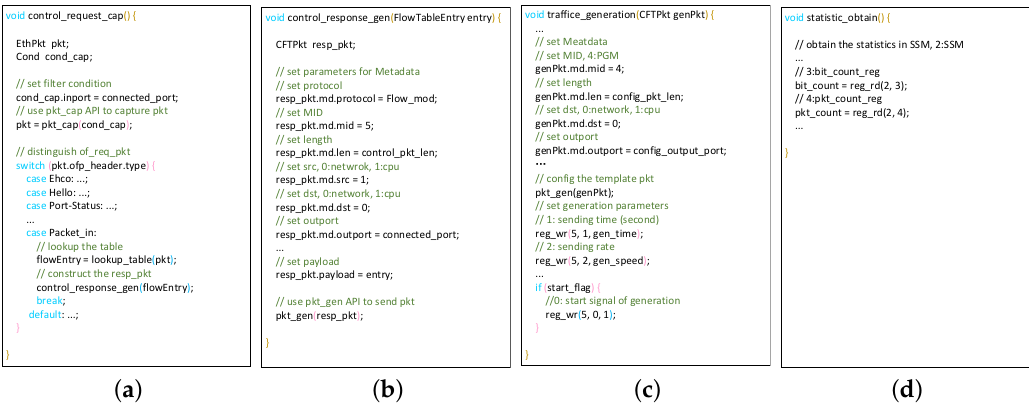
Figure 6. The application examples of the provided APIs.; ( a ) request control plane pakcet, ( b ) respond control plane packet, ( c ) traffic generation, ( d ) obtain